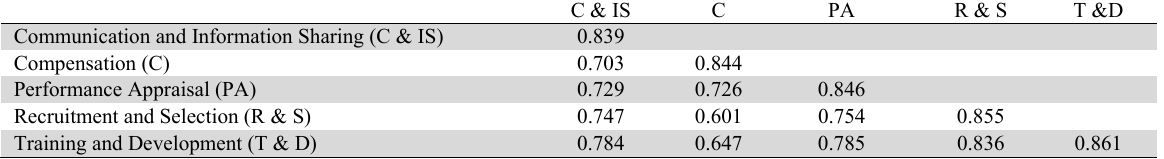
Fornell-Lurker Criterion Analysis for Checking Discriminant